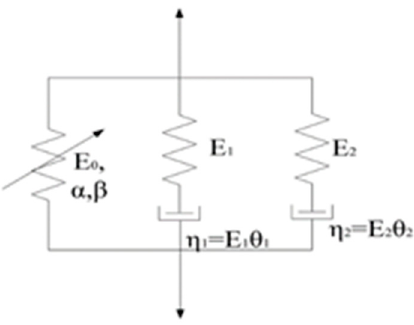
Figure 11. Schematic diagram of ZWT model [24].